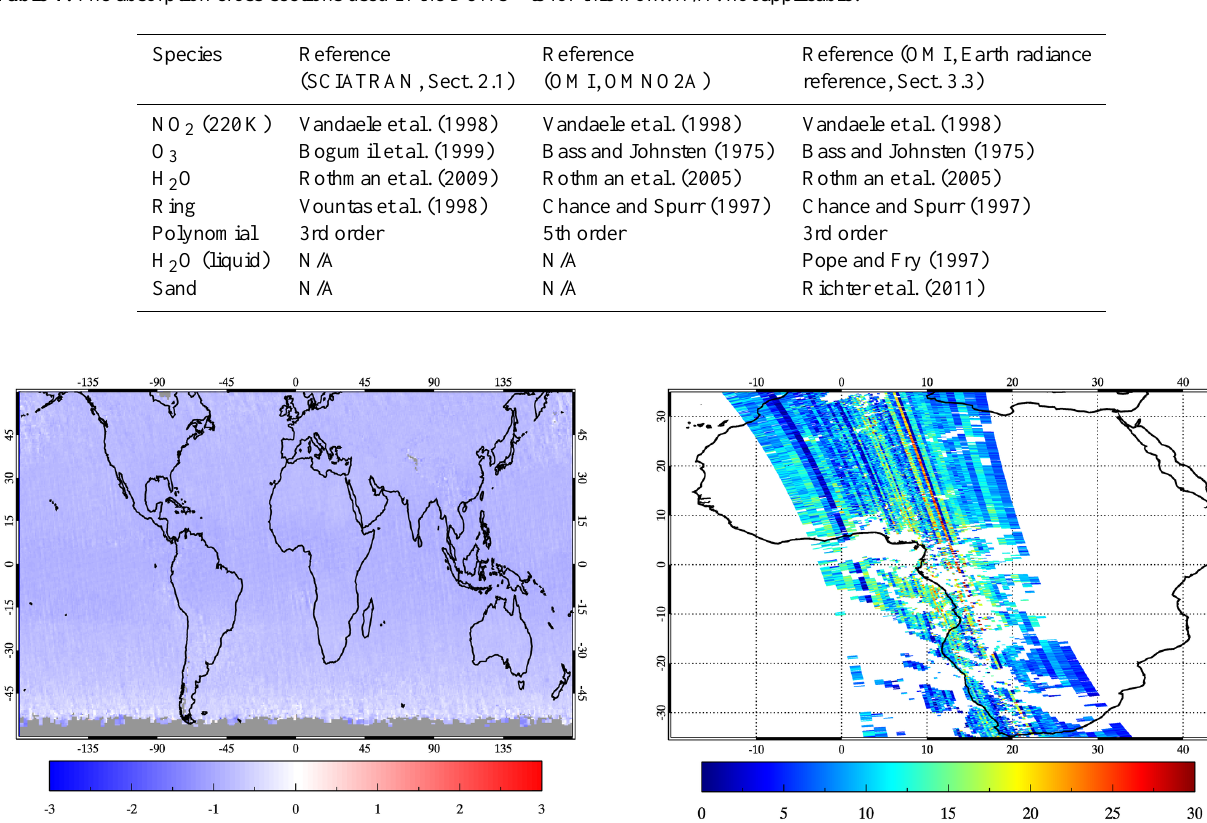
Table 1. The absorption cross-sections used in the DOAS fits for this work. N/A: not applicable.